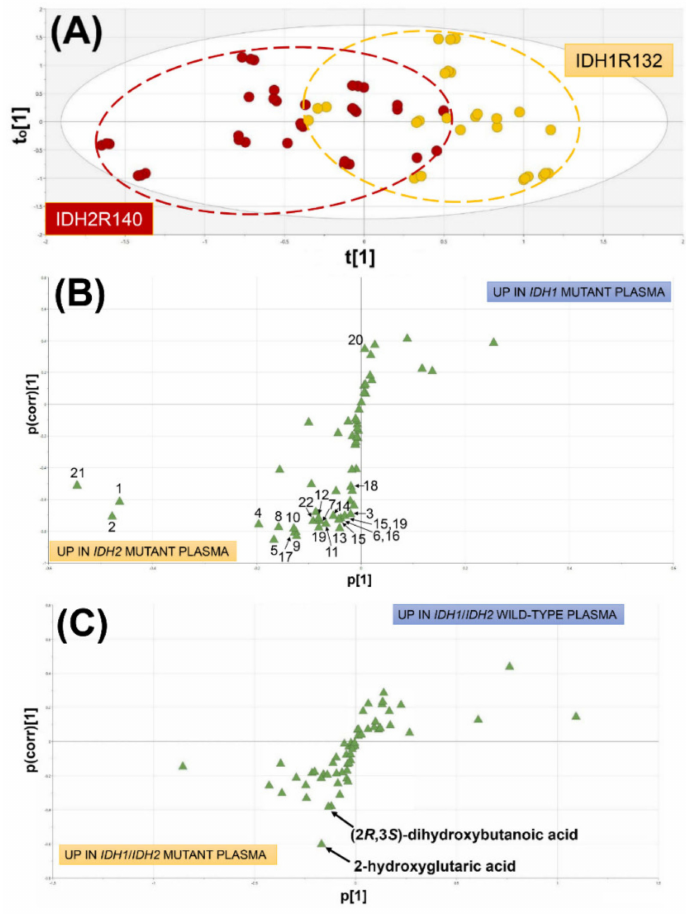
Figure 1. Plasma metabolomic analysis of acute myeloid leukemia (AML) patients with IDH1R132 versus IDHR140 mutations and wild-type (WT) IDH1 / 2 patients versus mutated IDH1 / 2 . ( A ) Orthogonal projectiontolatentstructures-discriminantanalysis(OPLS-DA)scoresplotforIDH1R132(yellow)versus IDHR140 (burgundy) showing clustering and partial separation of the two metabolic phenotypes. t[1] and t 0 [1] are the first principal component and the first orthogonal component, respectively. ( B ) OPLS-DA loadings S-plot showing the up- and down-regulated plasma metabolites responsible for the separation in scores in ( A ). Upper right and lower left quadrants represent the metabolites that are upregulated in IDH1 mutant plasma and IDH2 mutant plasma, respectively. Metabolites labeled 1 to 22 correspond to those listed in Table 1. p[1] and p(corr)[1] are related to relative concentration and correlation to the model, respectively. ( C ) OPLS-DA loadings S-plot showing the upregulated plasma metabolites in WT IDH1 / IDH2 (upper right quadrant) and mutant IDH1 / IDH2 (lower left quadrant) AML patients. Note that only two statistically significantly di ff erent metabolites were found between WT and mutant AML plasmas, 2R-HG, as expected, and the unexpected finding of